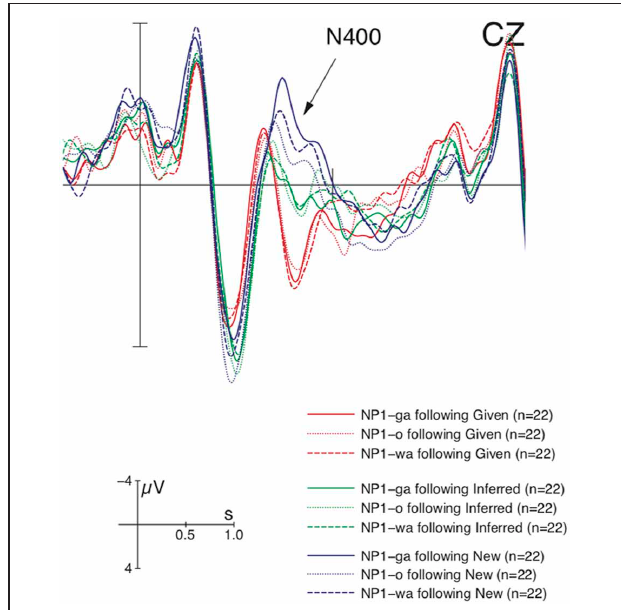
FIGURE 5 | Grand average ERPs ( n = 22) time-locked to NP1 in Experiment 2 (onset at the vertical bar) for the comparison of ga vs. o vs. wa in the Given, Inferred, Contrastive New contexts. Only the NP1 in the new context engendered a marker-modulated N400 in comparison with the other two contexts. Negativity is plotted upwards.